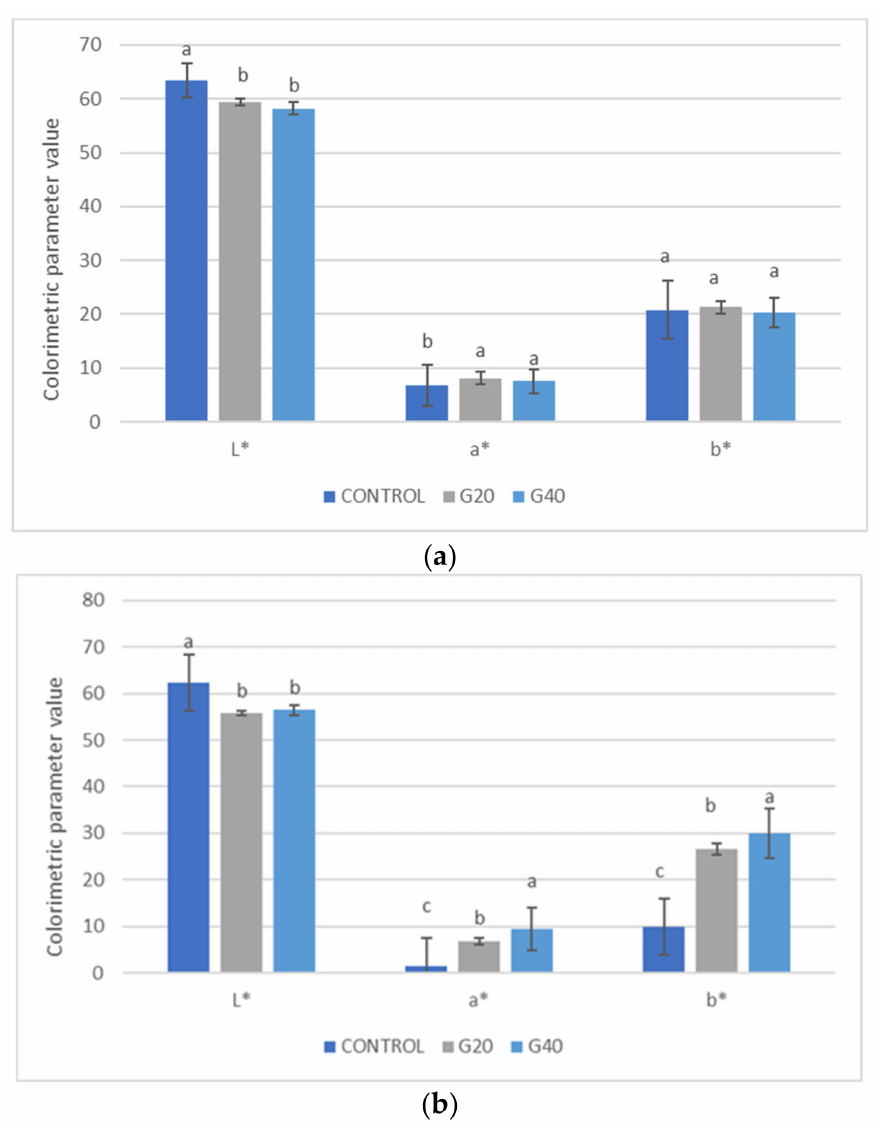
Figure 2. Colourimetric parameters (L*, a* and b*) in external ( a ) and internal ( b ) ciabatta bread and enriched ciabatta bread (with 20% and 40% goji puree). Differences between samples were evaluated by one-way ANOVA followed by Tukey’s test. Results followed by different letters are significantly different at ** p <